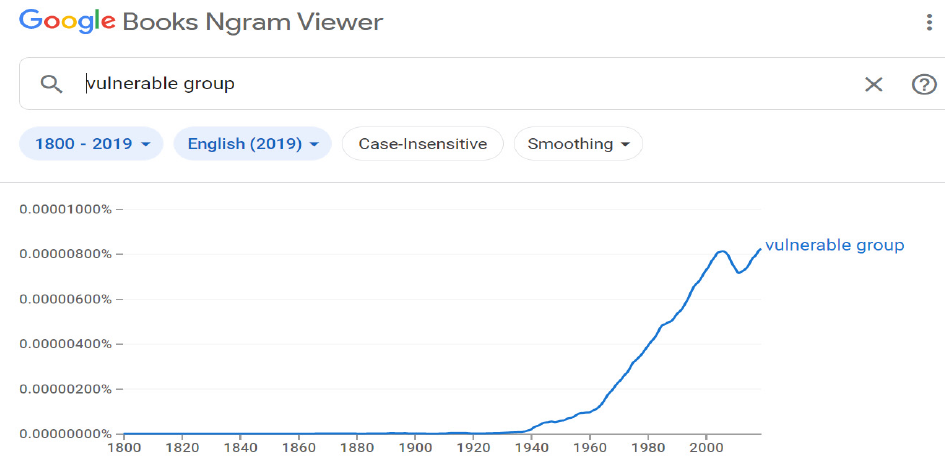
Figure 2. Google Ngram Searching Result of term ‘Vulnerable Group’.